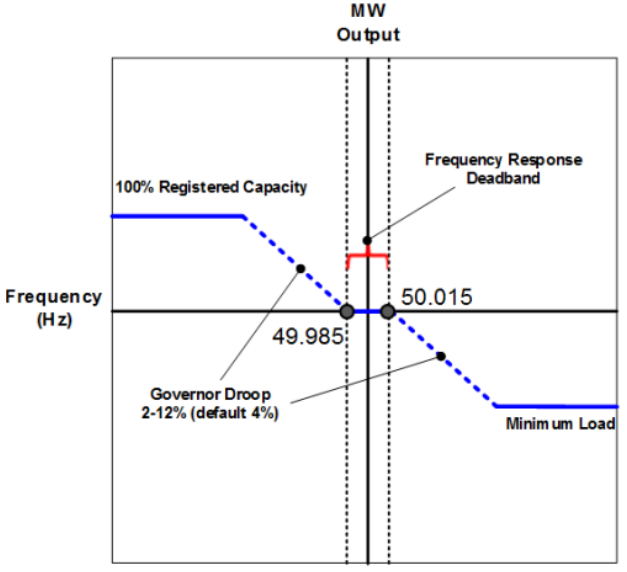
Figure 3. Droop requirements from the Irish grid for when the frequency sensitive mode is active.